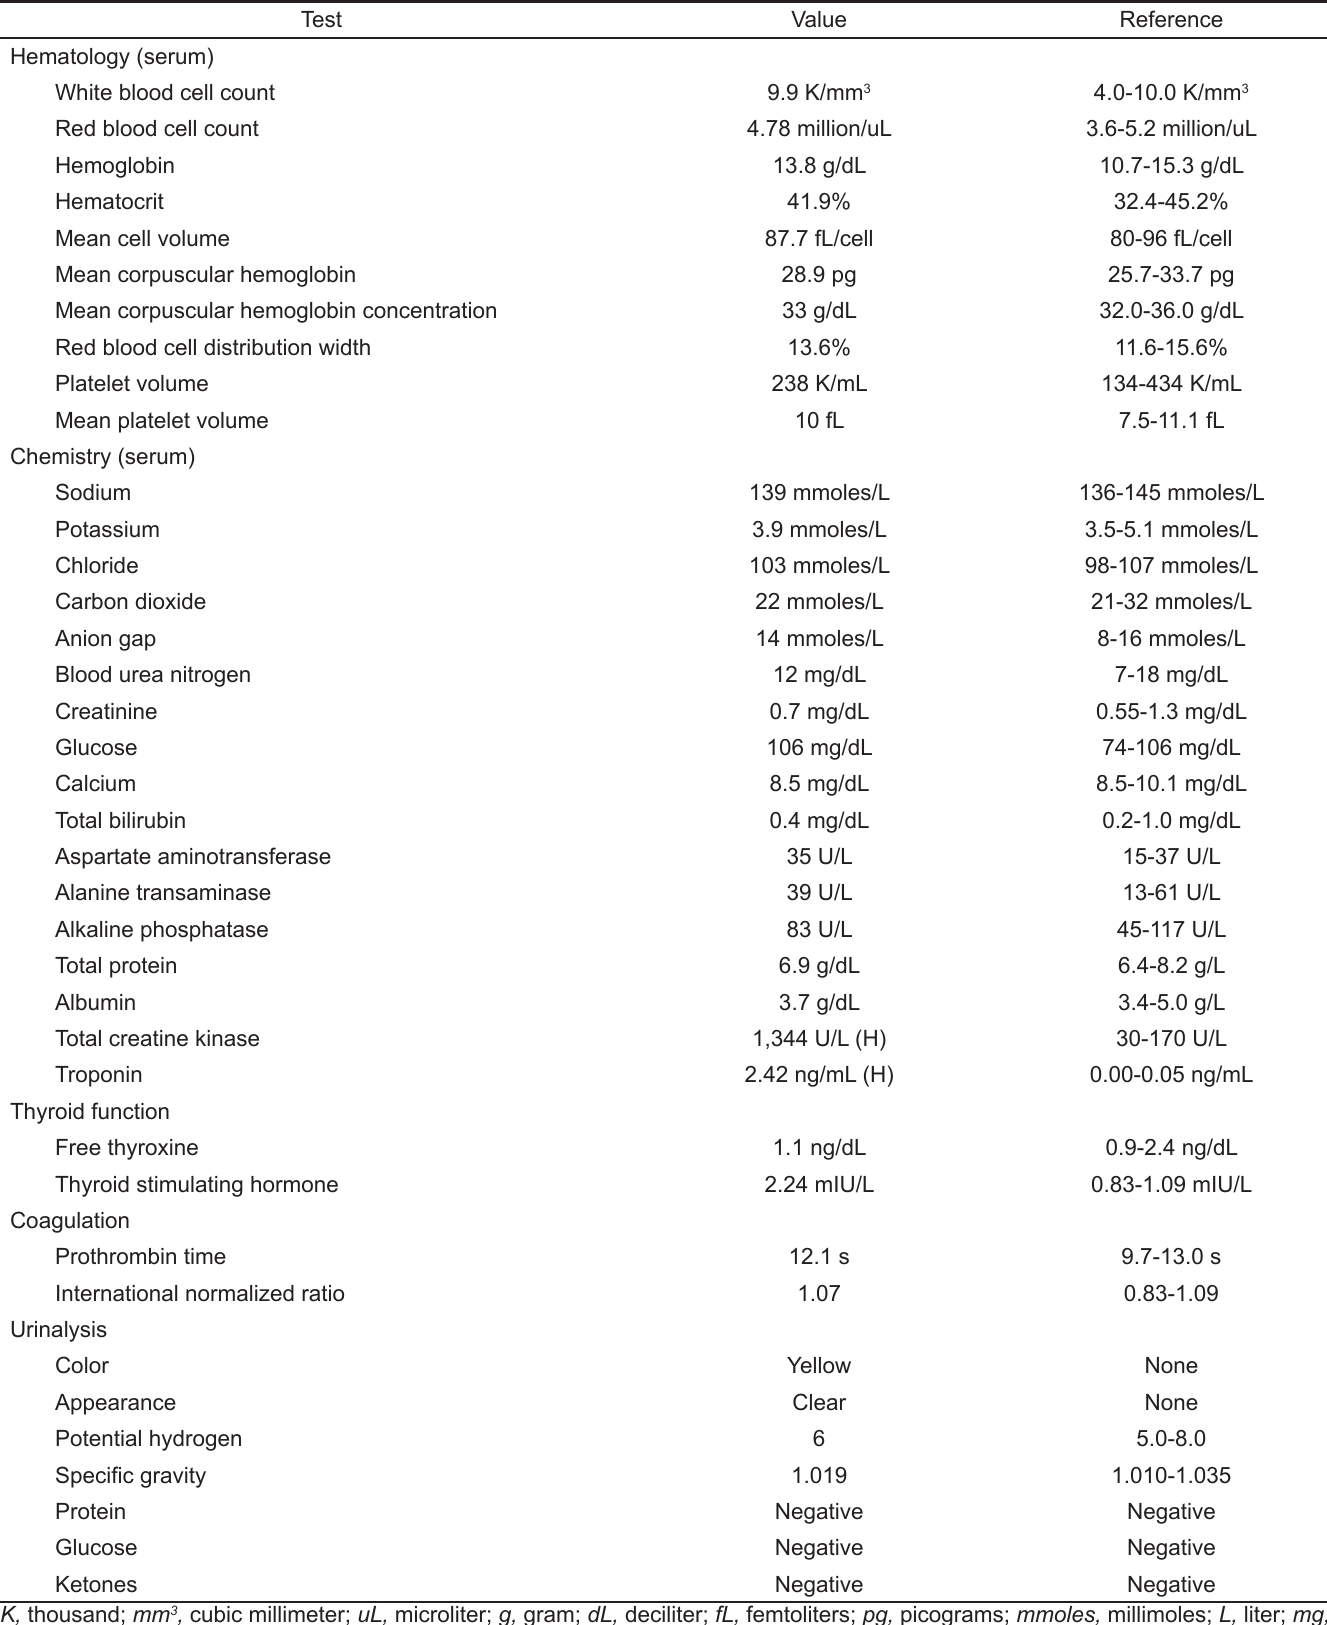
Table 1. Emergency department laboratory results. Abnormal values are flagged with